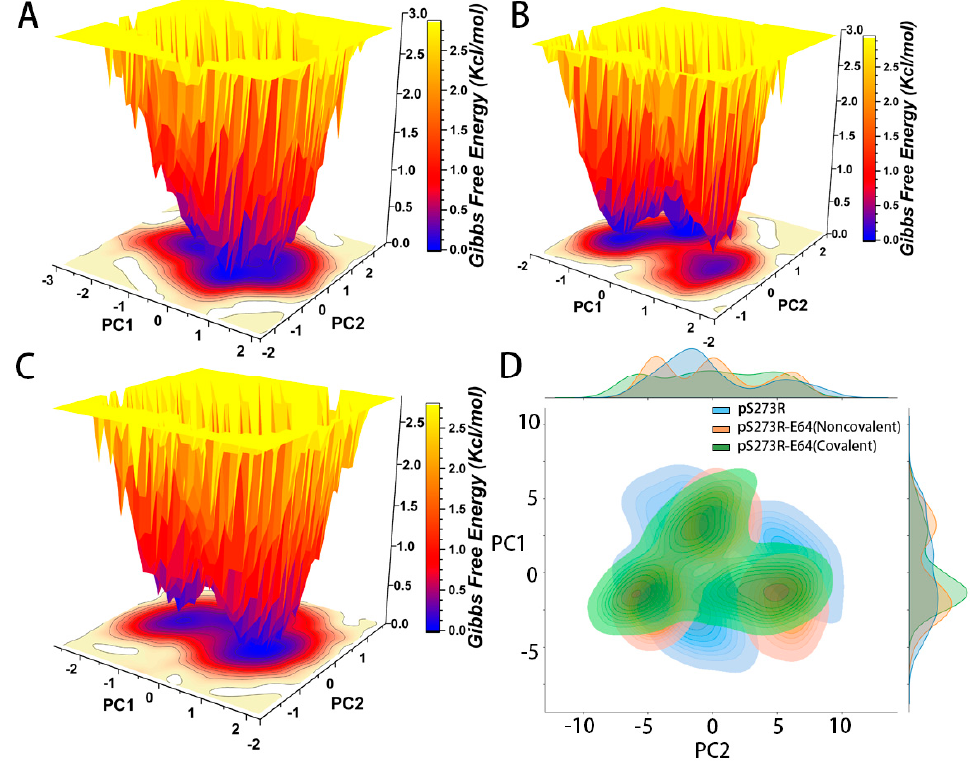
Figure 6. The analysis of pS273R and pS273R − E64 complexes in different bonding states based on FEL (Kcal/mol) and PCA. ( A ) FEL of pS273R in the free state. ( B ) FEL of pS273R − E64 (Noncovalent). ( C ) FEL of pS273R − E64 (Covalent). ( D ) The analysis for pS273R and pS273R − E64 complex based on PCA.